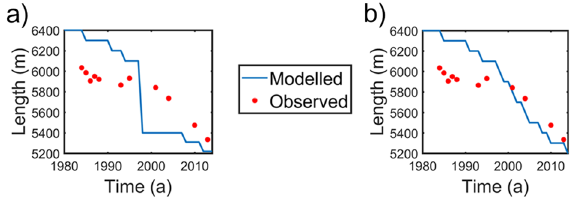
Figure 9. A comparison of glacier length fluctuations with and without calving scheme. ( a ) Calving. ( b ) No Calving. (URL: www. mathw orks.